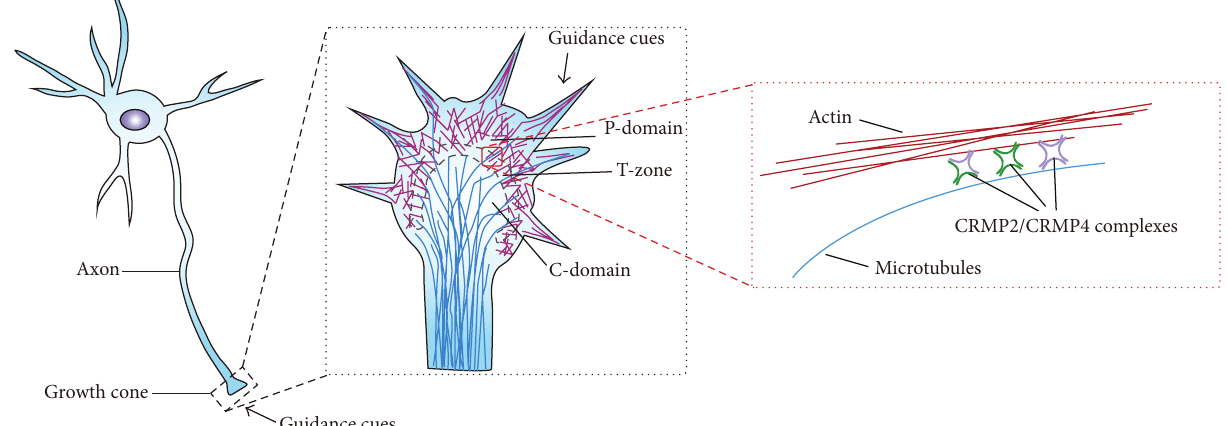
Figure 7: Diagram of a model for CRMP2 and CRMP4 coordinately regulating growth cone development and axon elongation via cytoskeleton dynamics. The schematic model shows that CRMP2 and CRMP4 may form complexes (homo- or heterotetramers) bridging microtubules and actin to mediate cytoskeleton dynamics, thus regulating growth cone development and axon